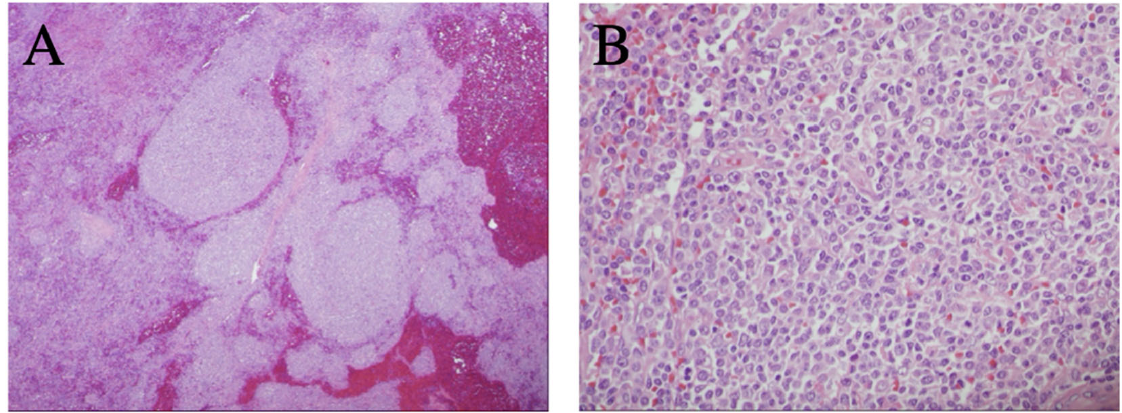
Figure 1. Representative histology observed in splenic tissue following splenectomy. ( A ) Expansion of splenic white pulp by marginal zone B ‐ cell lymphoma without a classic targetoid pattern (H&E stain, 40×); ( B ) heterogenous lymphoma cells, including a mildly increased proportion of large/centroblastic cells and occasional mitoses, focally (H&E stain, 400×).